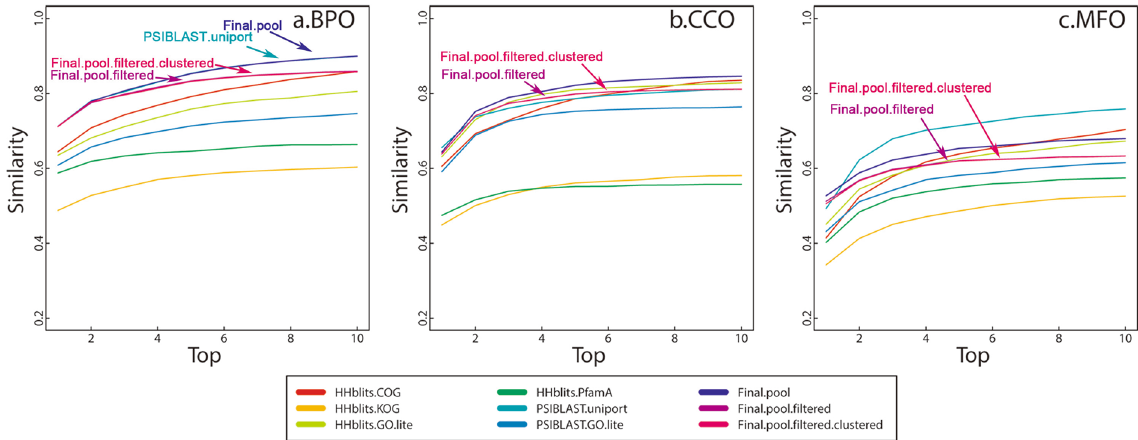
Figure 5. The maximum similarity score between predicted and real GO terms. ( a ) Performances for Biological Process Ontology (BPO). The PSI-BLAST-uniprot and Final-pool are overlapping (the line on the top); whereas Final-pool-filtered-clustered and Final-pool-filtered are overlapping (the second line from the top). ( b ) Performances for Cellular Component Ontology (CCO). Notice that the Final-pool achieves the best performance. Final-pool-filtered-clustered and Final-pool-filtered are overlapping with each other (the third line from the top when considering top 4 predictions). ( c ) Performances for Molecule Function Ontology (MFO), in which the PSI-BLAST-uniprot achieves the highest semantic similarity.